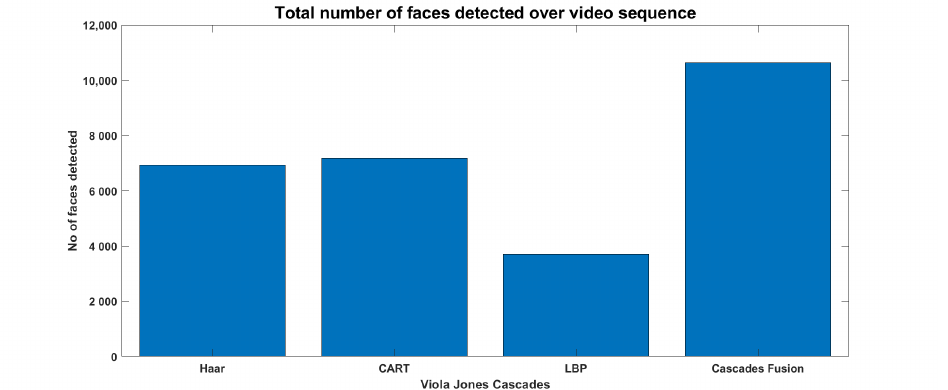
Figure 12. Detected faces counts on entire video